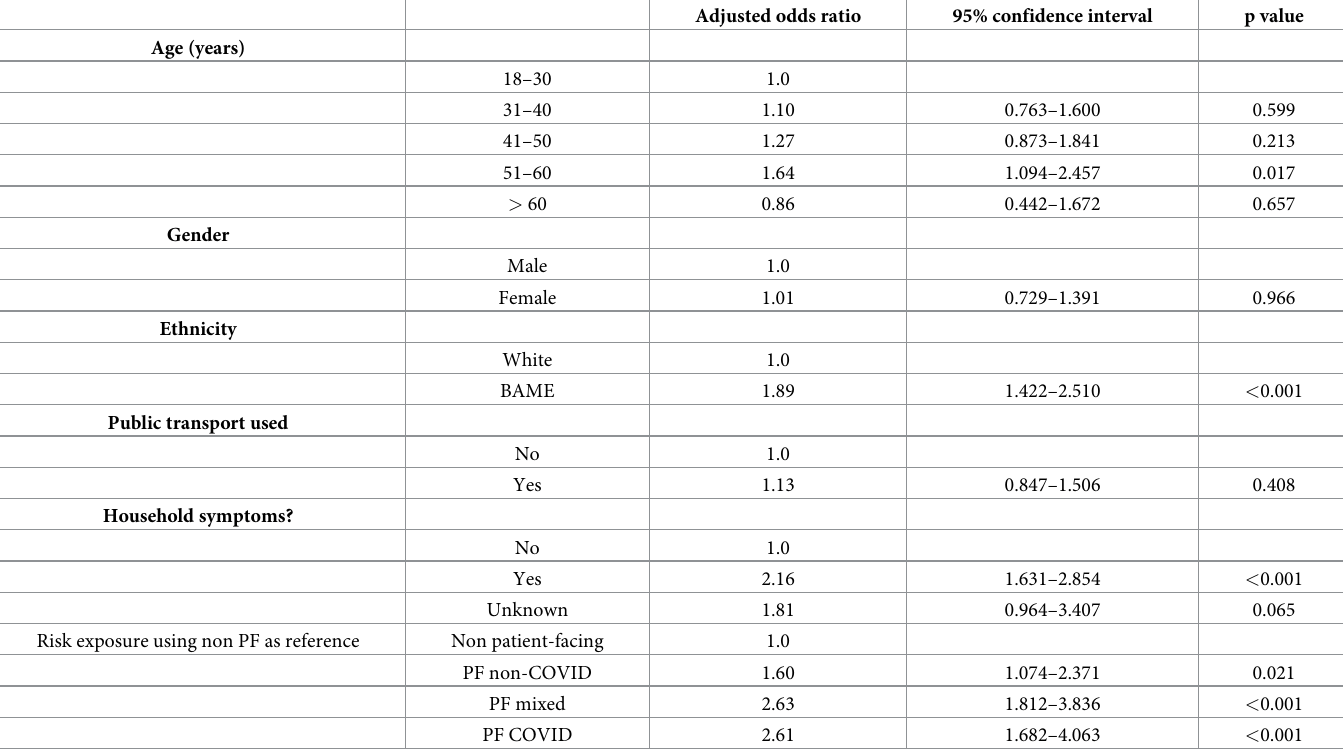
Table 2. Multiple logistic regression of the risk of infection on selected predictors.